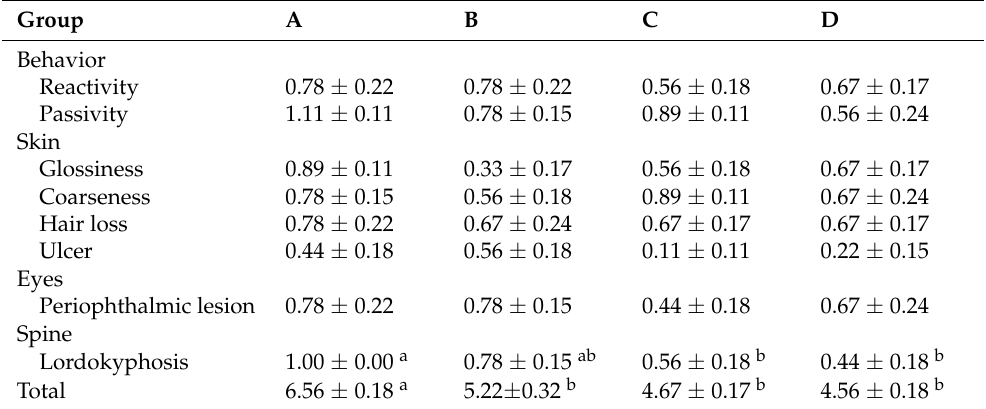
Table 6. Effects of SPE administration on aging index assessment scores of female SAMP8 mice.